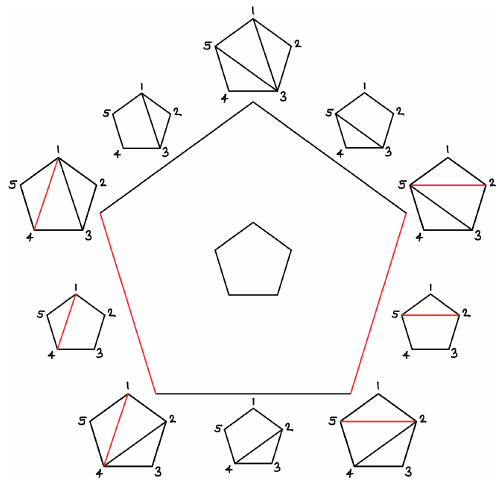
Figure 9 . Associahedron block A 14